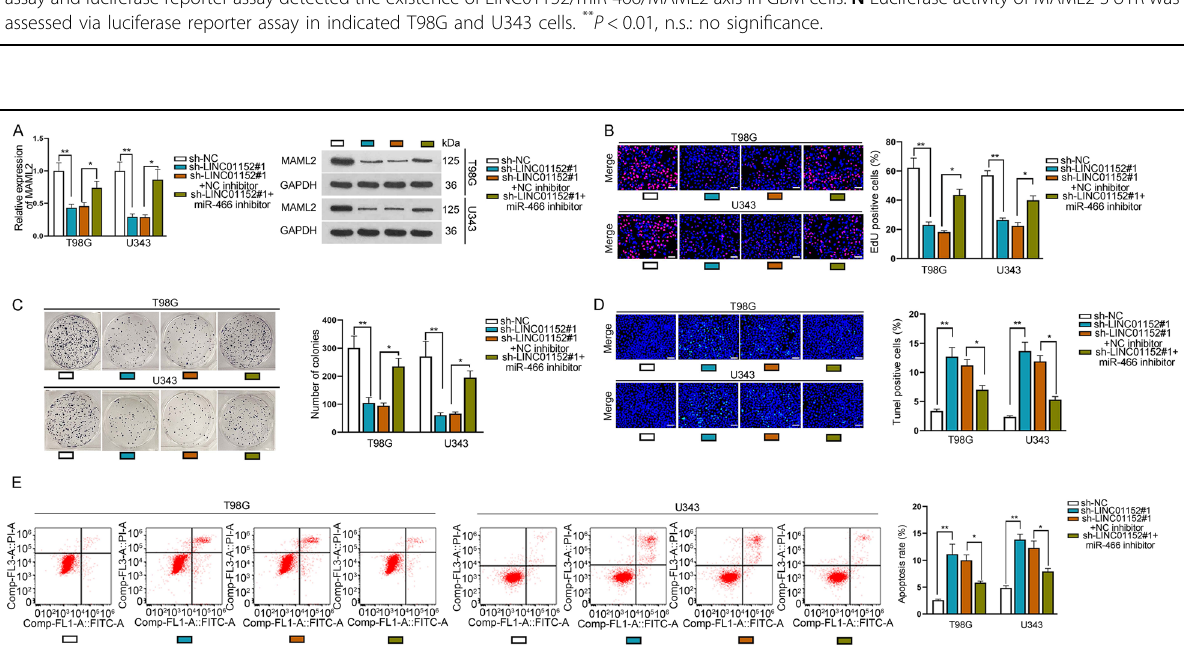
lysis (Fig. 4D, E). In a word, LINC01152 partially relied on